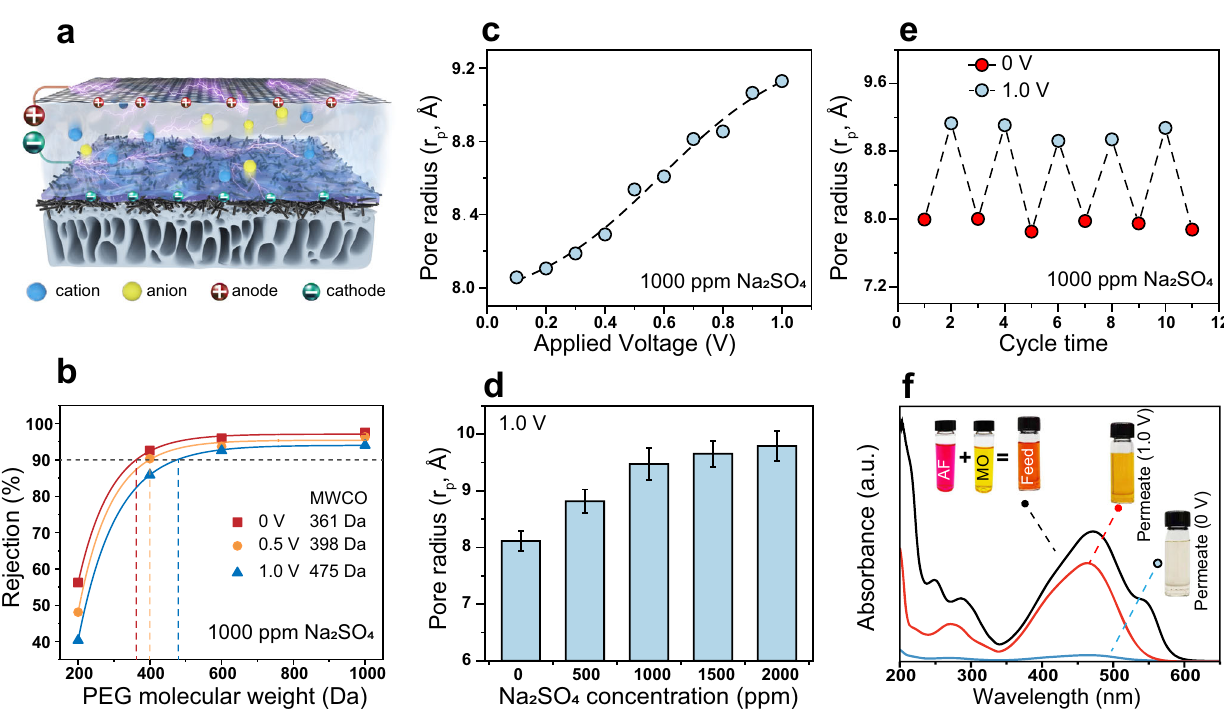
radius of the CNTs-PA membrane when applied voltage switches between 0 and 1.0V. f Demonstration of operando regulation of dye separation performance via adjustingthevoltageappliedontheCNTs-PAmembrane.For c – e ,theporeradiiare estimated using the hinder transport model with rejections of PEG of different molecular weights as the inputs. Error bar represents the standard deviation of three replicate measurements. Source data are provided as a Source Data fi